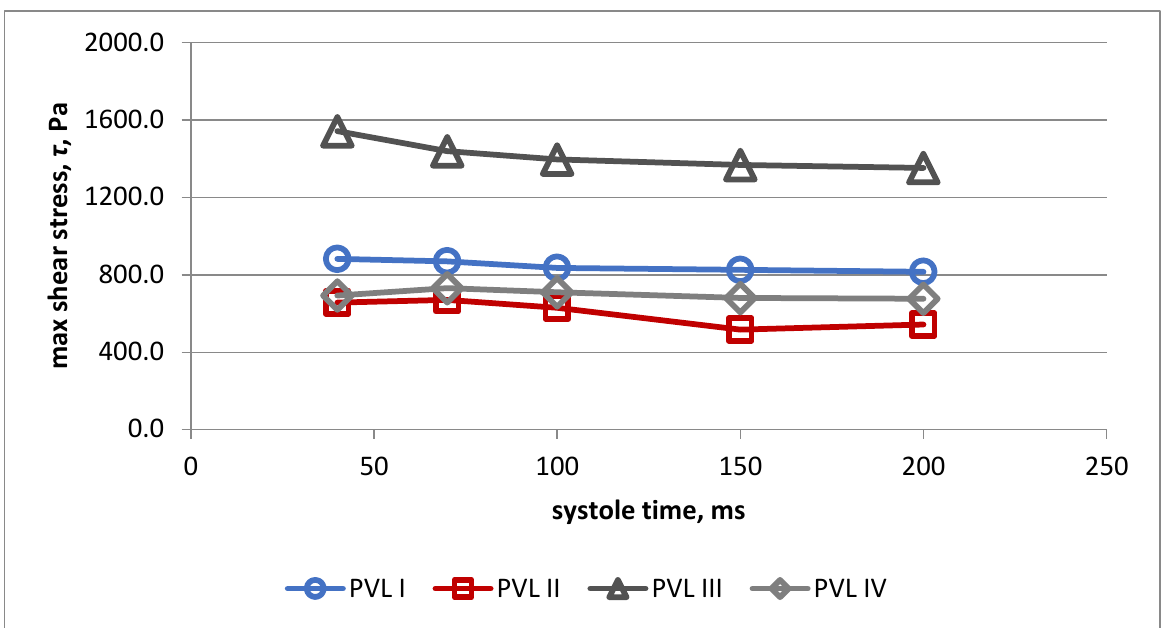
Figure 9. Maximal shear stress in fluid during systole for all PVL models.